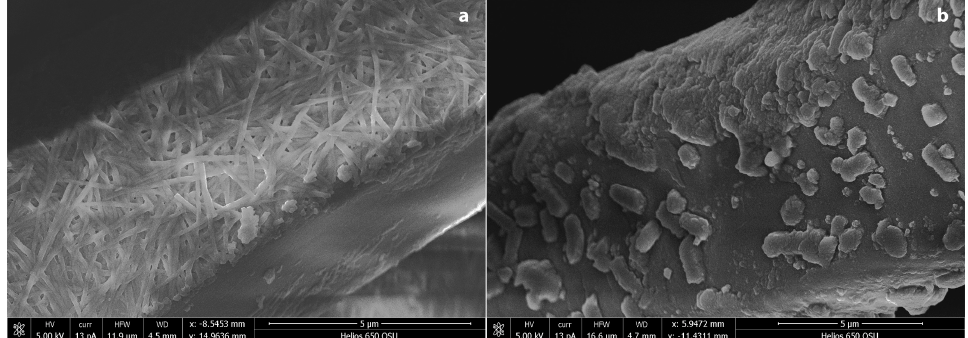
Figure 11. ( a ) Polyester printed with CTAB; ( b ) Polyester printed with ethanol. Images taken with a FEI Helios 650.